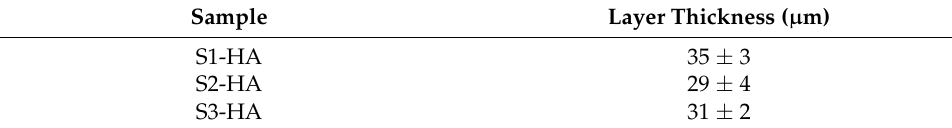
Figure 3. EDS elemental mapping of the metallic surface: ( a ) S1-HA; ( b ) S2-HA; ( c ) S3-HA. Table 4. The thickness of the deposited layers.